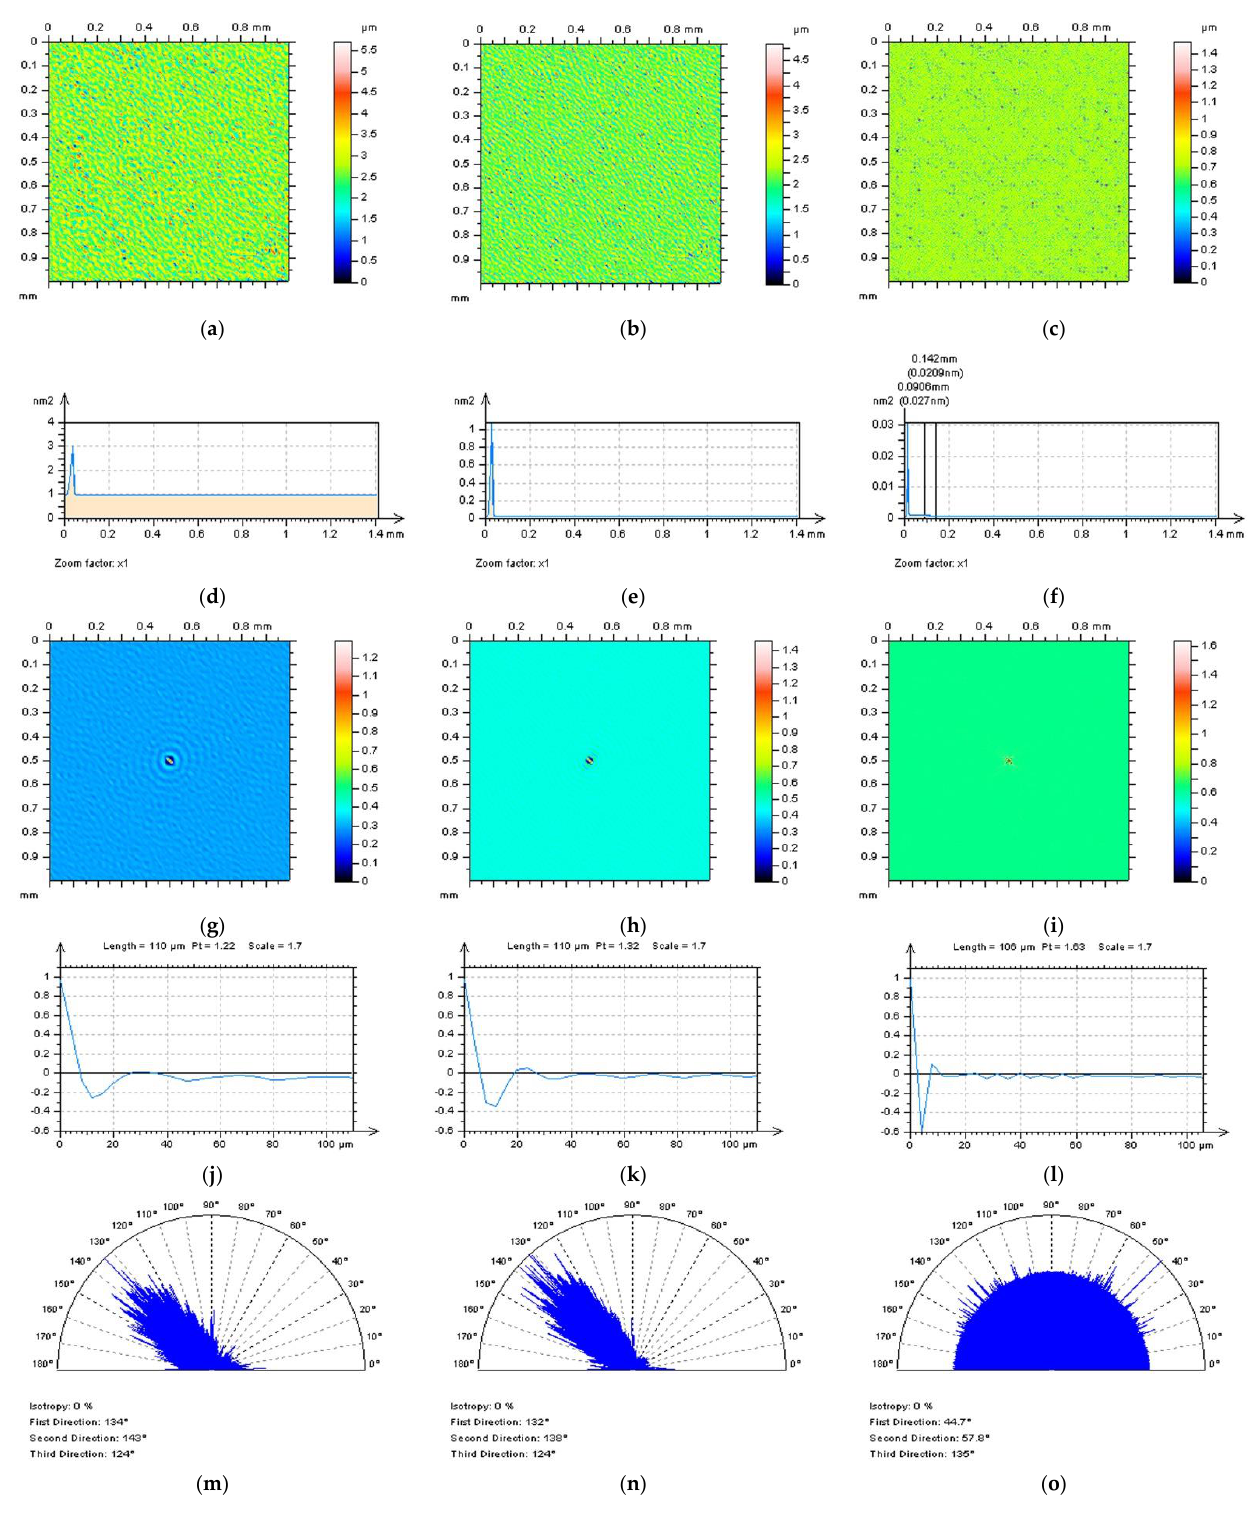
Figure 10. Contour map plots ( a − c ), its 3D PSDs ( d − f ), 3D ( g − i ), and 2D ( j − l ) ACFs and, correspondingly, TDs ( m − o ) of NSs received by an application of FFTF with cut-off equal to: 0.035 mm (left column), 0.025 mm (middle), and 0.015 mm (right column), obtained for surface B.